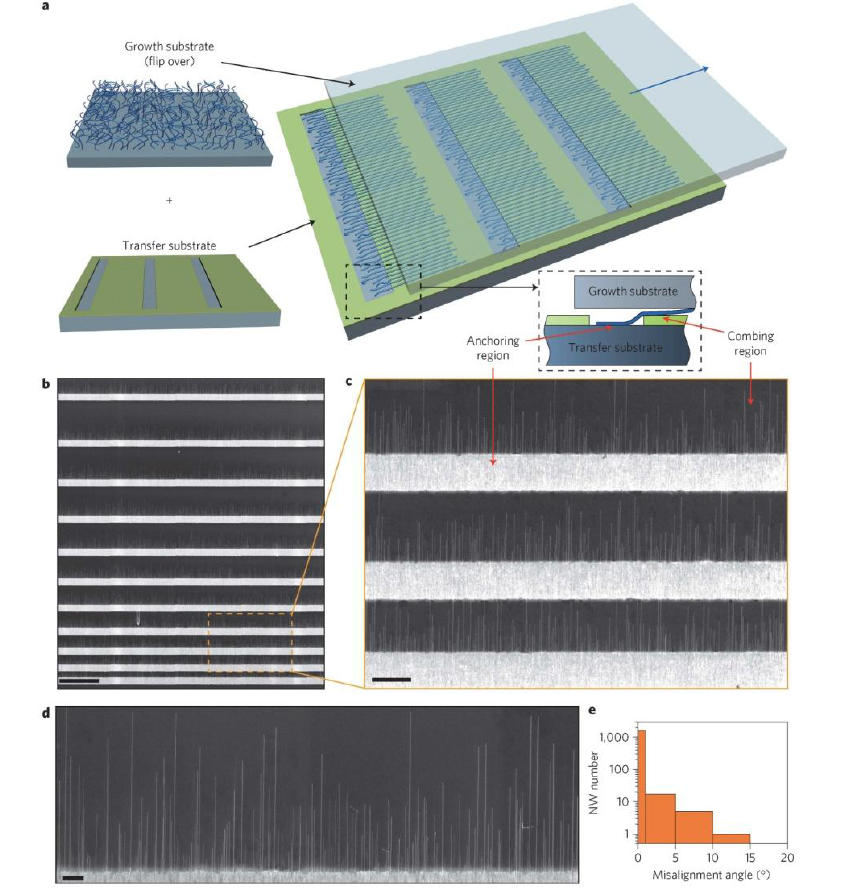
Figure 4. Nanowire device arrays. ( a ) Dark-field image of silicon nanowire arrays. The anchoring windows were defined by photolithography, and the resist layer (S1805) thickness was 70 nm. Scale bar, 100 mm; ( b ) SEM image of one of the combed nanowire arrays on the resist layer. Scale bar, 2 mm; ( c ) Dark-field image of trimmed nanowire arrays (resist layer removed). Scale bar, 40 mm; ( d ) Optical image of nanowire device arrays connecting to electrode arrays. Scale bar, 200 mm; ( e ) Representative SEM image of one of the device arrays. Scale bar, 2 mm; ( f ) I -V characteristics (V = 0.1 V) from 20 top-gated ds g ds 3.8 mm, with Al O (7 nm) serving as the dielectric layer for the top gate (Cr/Au 1/4 5/50 2 3